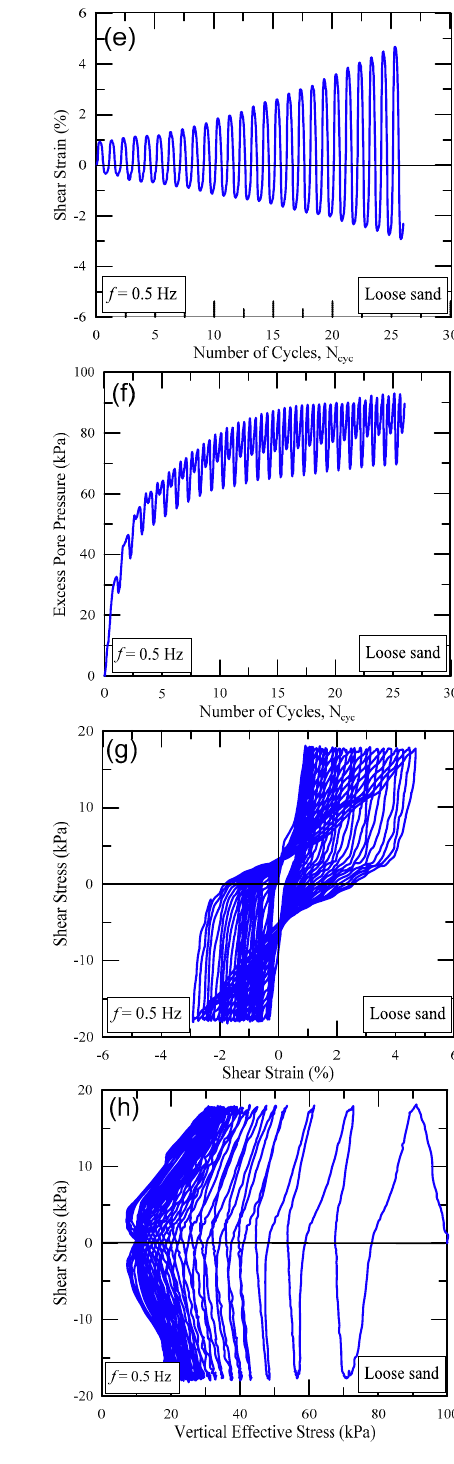
Figure 4. Undrained response of loose sand at σ v0 ′ = 100 kPa and cyclic stress ratio (CSR) = 0.18: ( a )–( d ) f = 0.05; ( e )–( h ) f = 0.5.